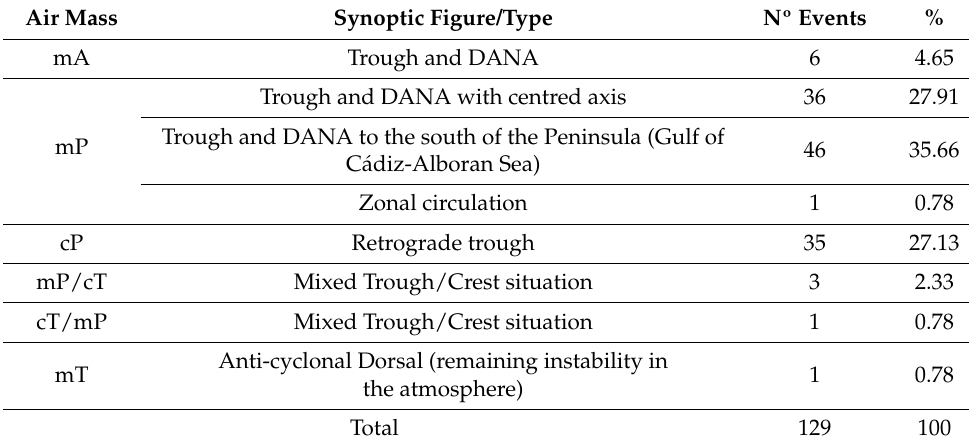
Figure 4. Examples representing the different synoptic situations for the classification by Mart í n Vide [20] on days presenting ≥ 100 mm of rainfall. Source: www.wetterzentrale.de (consulted 24 March 2022). Table 3. Atmospheric situations causing intense rainfall episodes analysed in the study according to Olcina Cantos